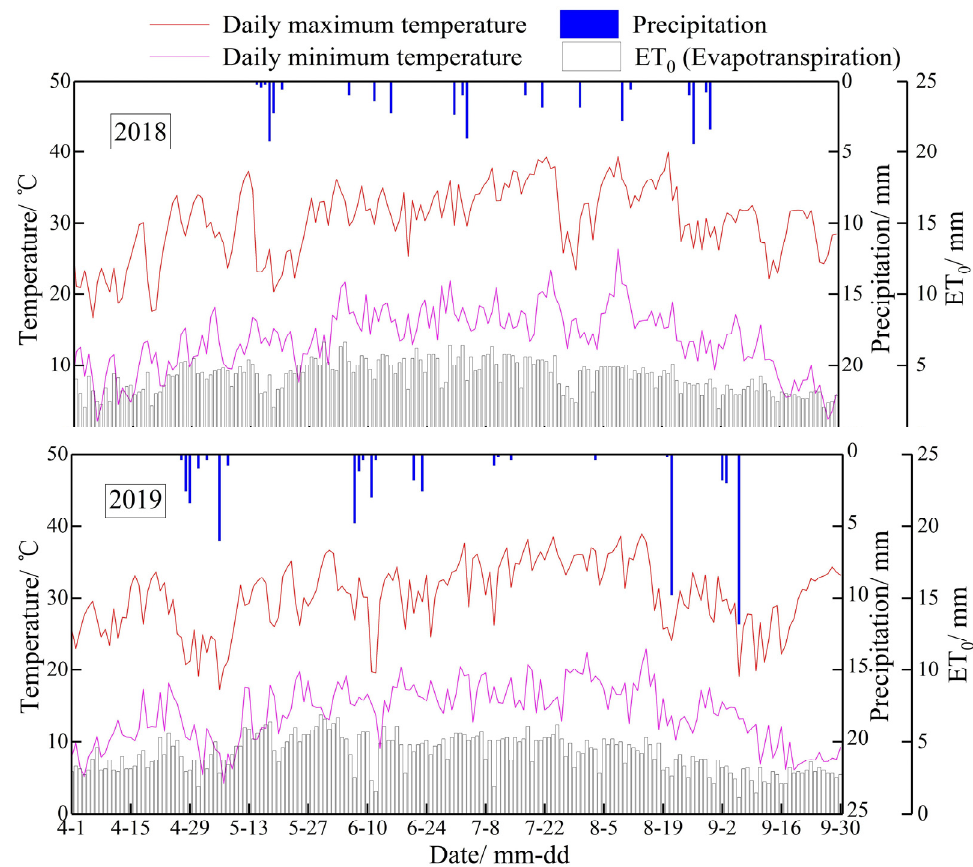
Figure 2. Meteorological data of the test area.